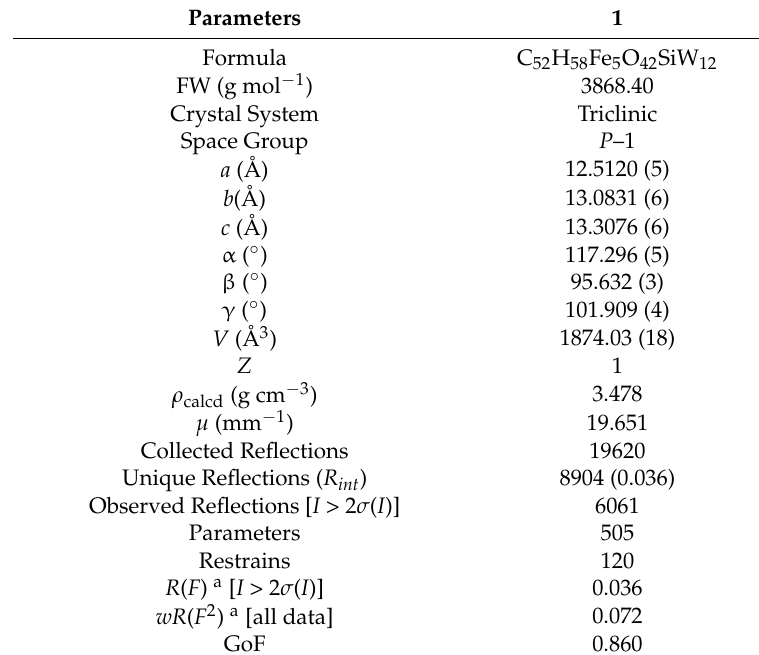
Table 5. Crystallographic data for 1